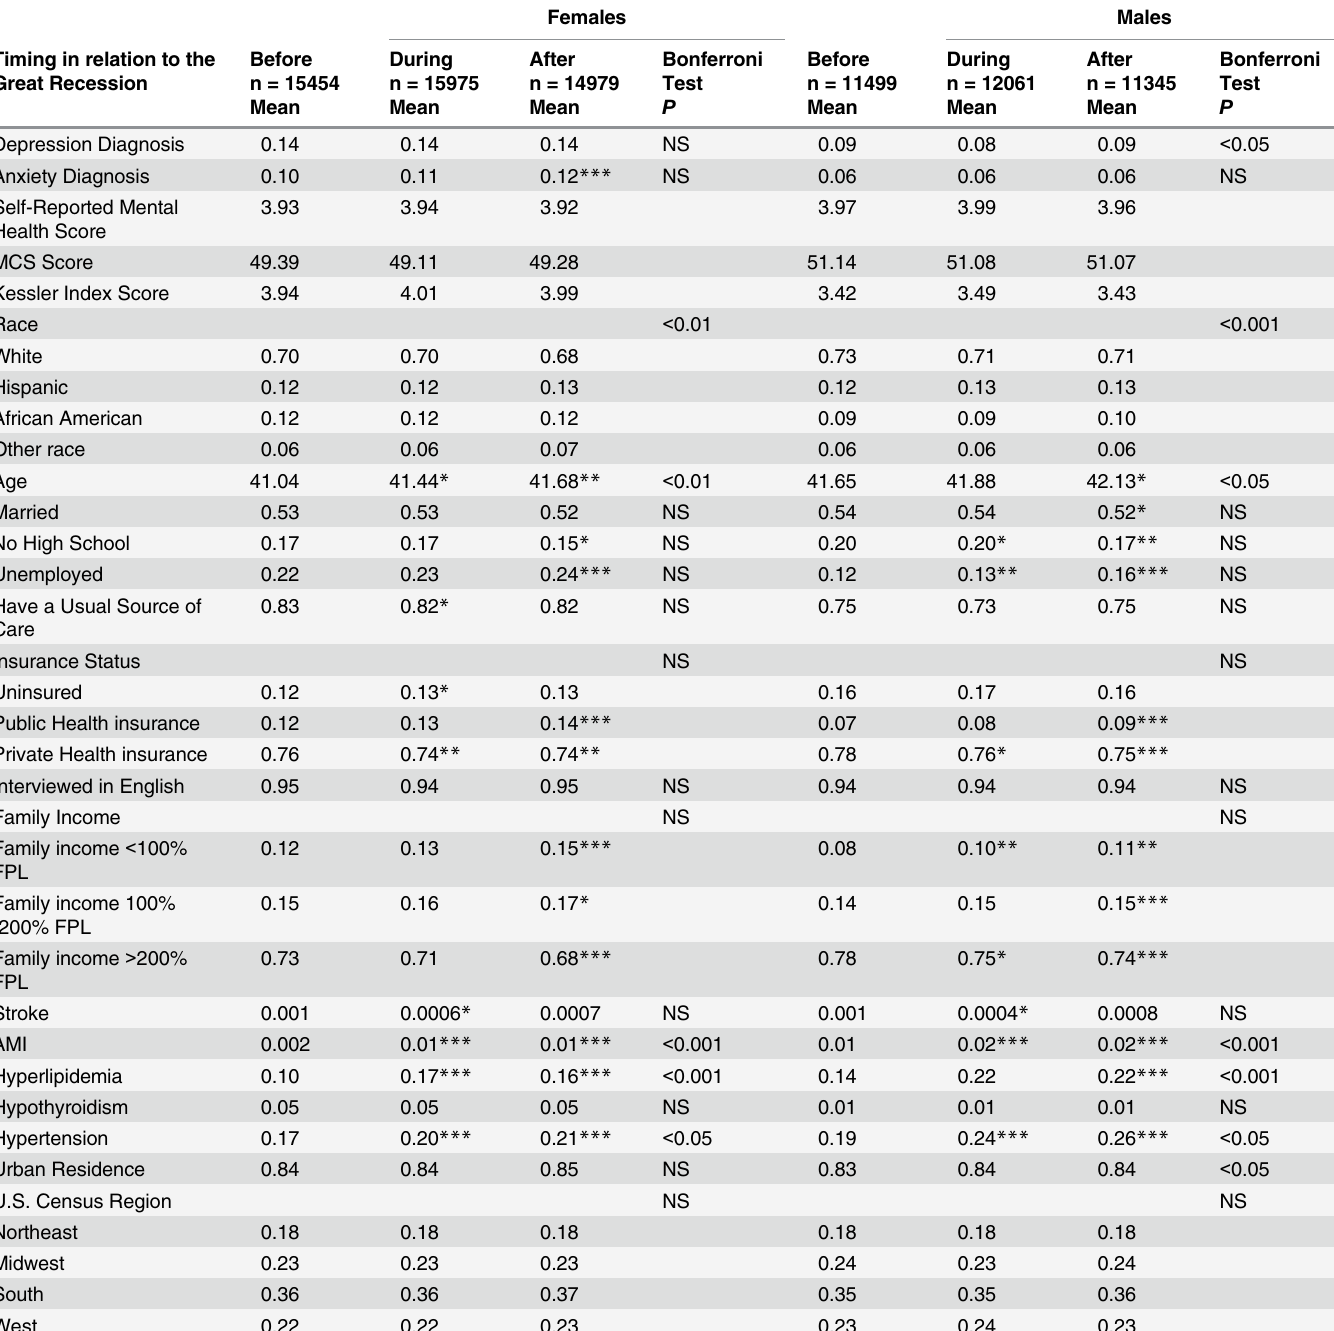
Table 1. Weighted summary statistics of the sample before, during, and after the recession † . Females